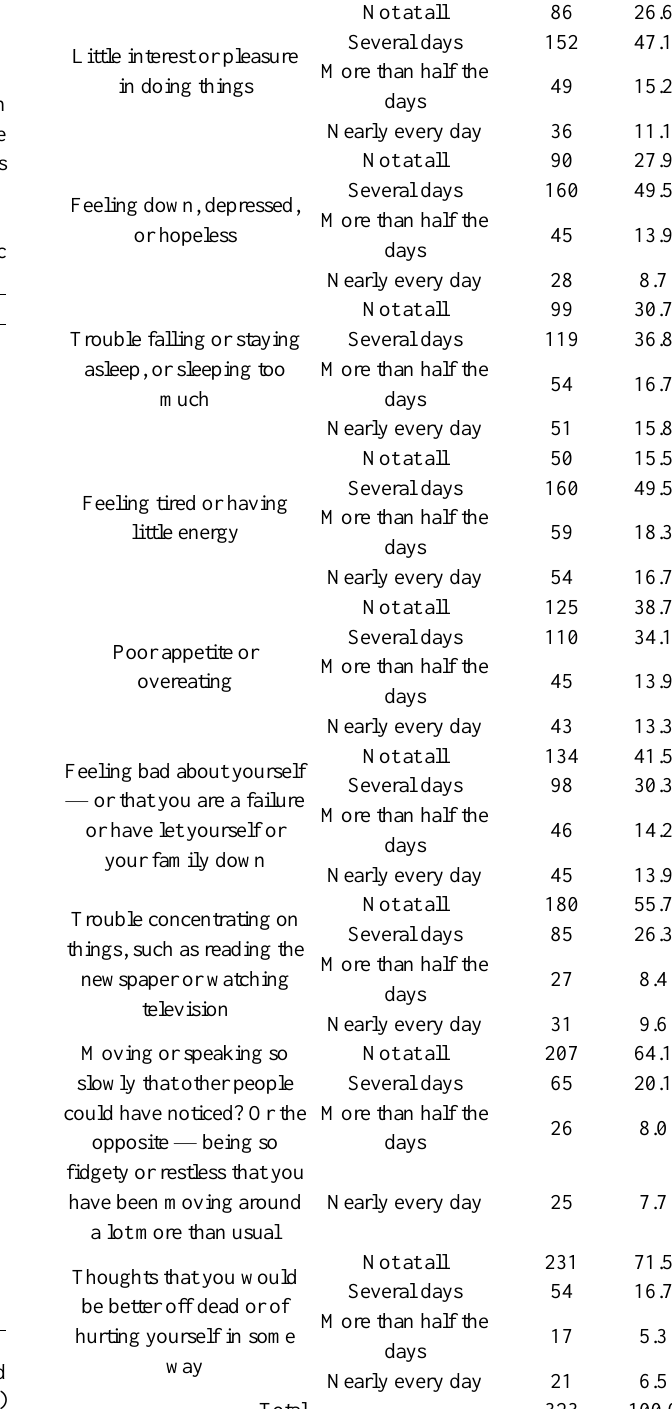
Table 2 : Distribution of participants according to PHQ